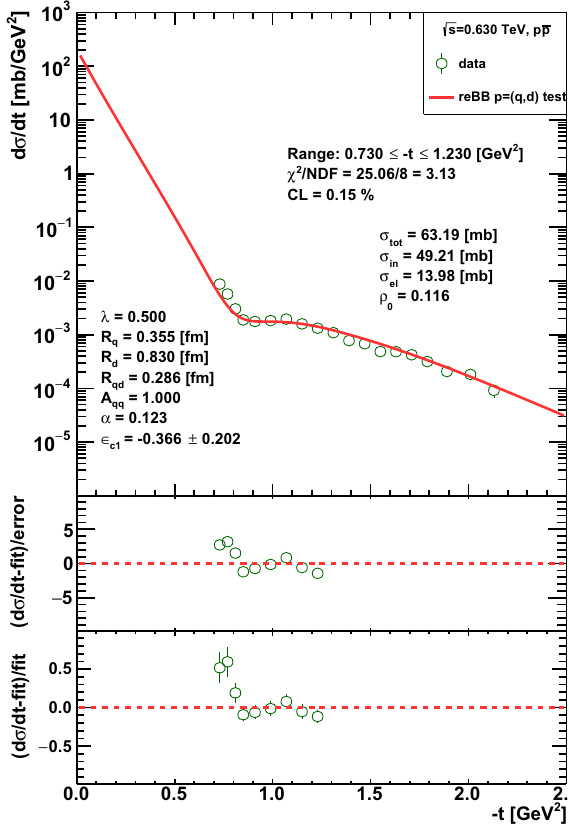
Fig. 9 Result of a sanity test, similar to Fig. 8, but for the TeV p ¯ p elastic differential cross section data of Ref. [66], fitted in the range 0 . 7 ≤ − t ≤ 1 . 2 GeV 2